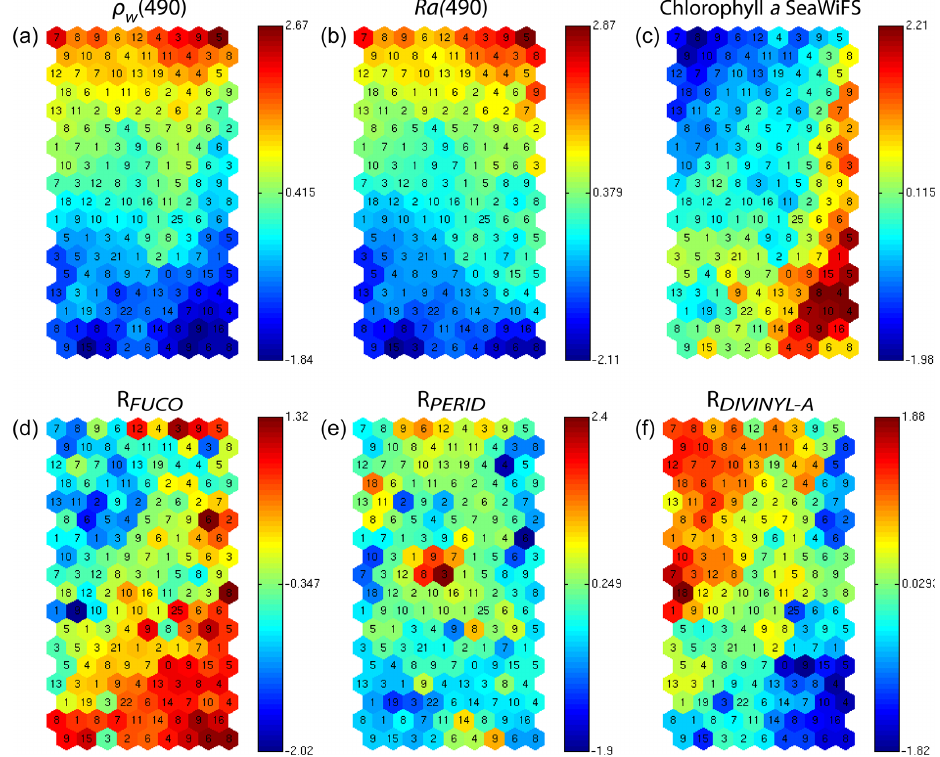
Figure 6. 2S-SOM. From left to right and top to bottom, values of the referent vectors for (a) ρ w ( 490 ) , (b) Ra ( 490 ) , (c) SeaWiFS chl a , and the (d) fucoxanthin, (e) peridinin and (f) divinyl ratios. The number in each neuron indicates the amount of DPIG data captured at the end of the learning phase; the values indicated by the color bars are centered–reduced nondimensional